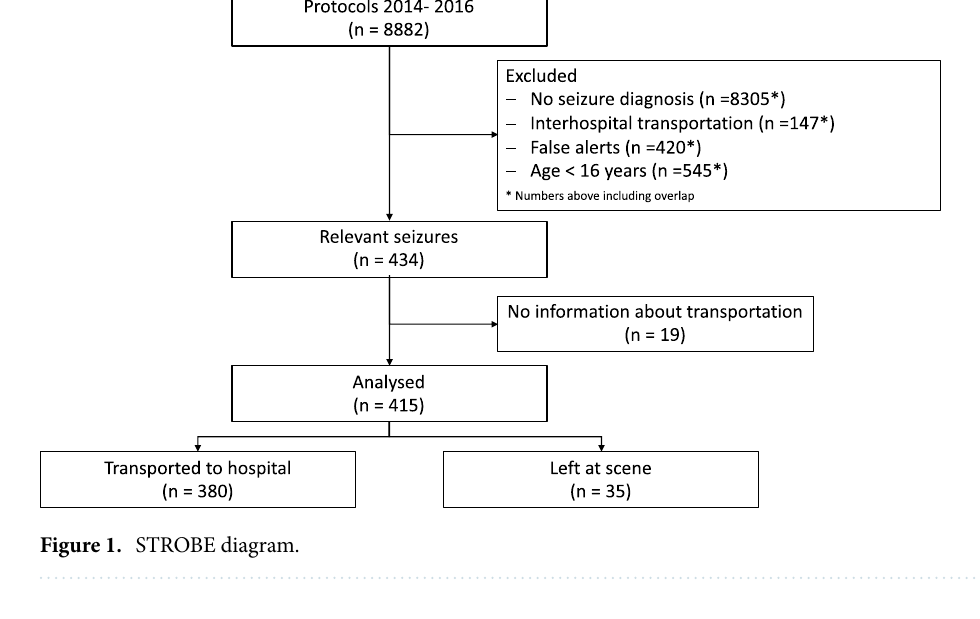
Patients without history of seizure/epilepsy, All patients, n = 415 n = 209